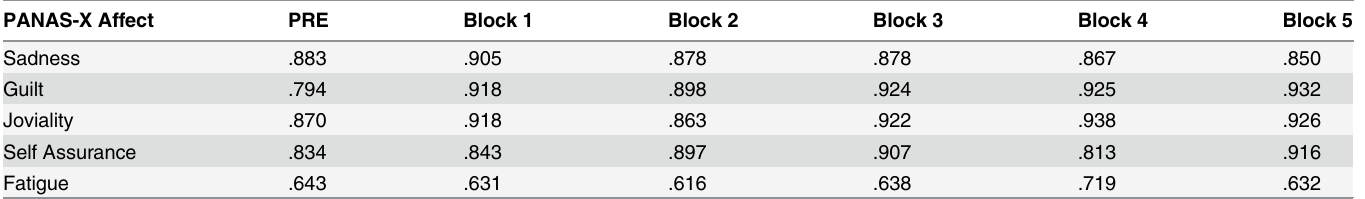
Table 1. Reliability (Cronbach ’ s alpha) of the PANAS-X affect scales administered at the beginning of Study 1 (PRE) and at the end of the five blocks. PANAS-X Affect